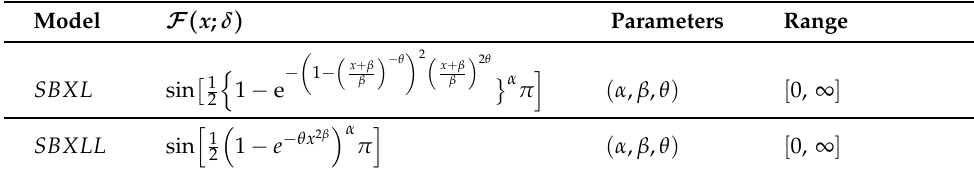
Table 4. CDFs of proposed models.